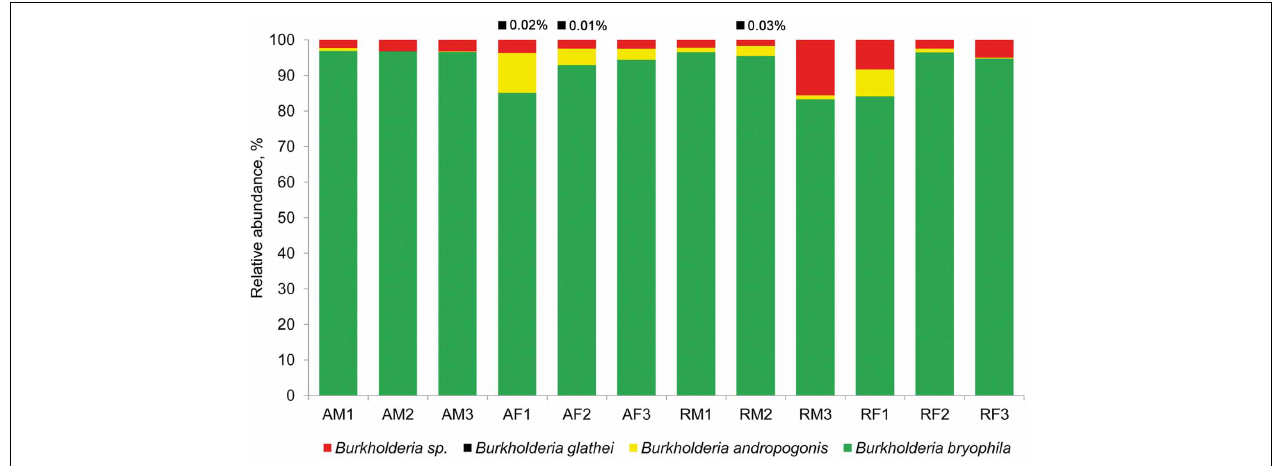
FIGURE 1 | Taxonomic classification of burkholderial communities associated with Sphagnum mosses. Bar charts represent the composition of Burkholderia -specific 16S rDNA pyrosequencing libraries classified using RDP-classifier with a confidence threshold of 80%. The burkholderial sequences that remained unclassified at the species